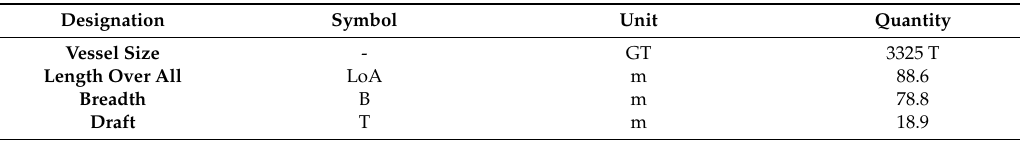
Figure 4. Coupled